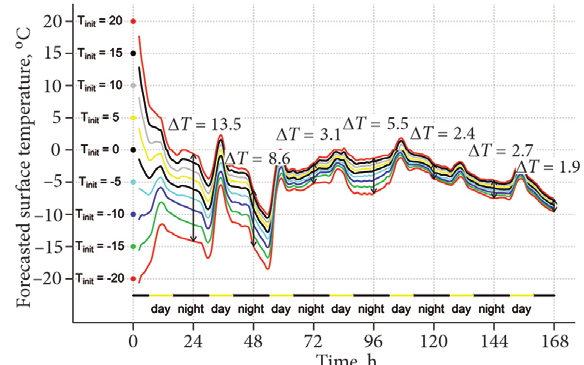
Fig. 2. Independently of the initial conditions the surface temperatures converge after a few